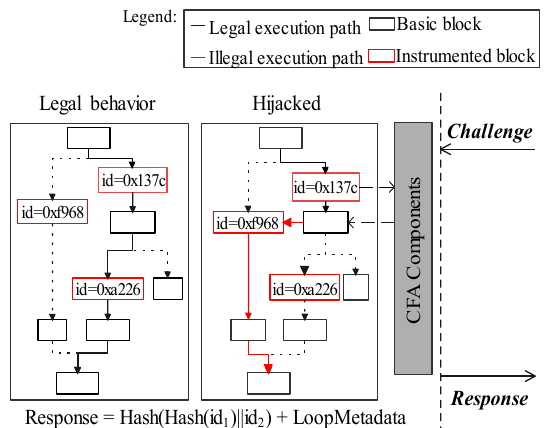
Figure 5. Attestation to a